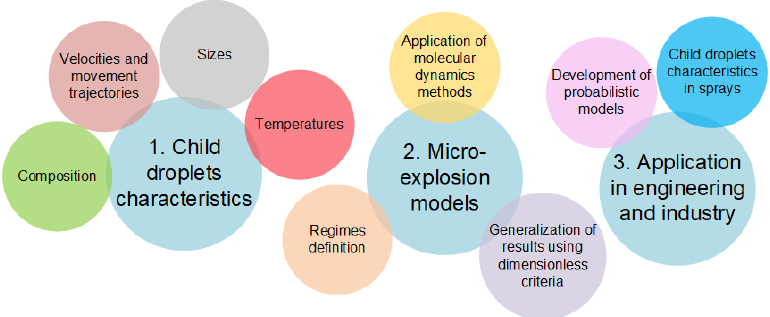
Figure 5. Schematic representation of promising trends in the development of science and technol- ogy related to micro-explosions. related to